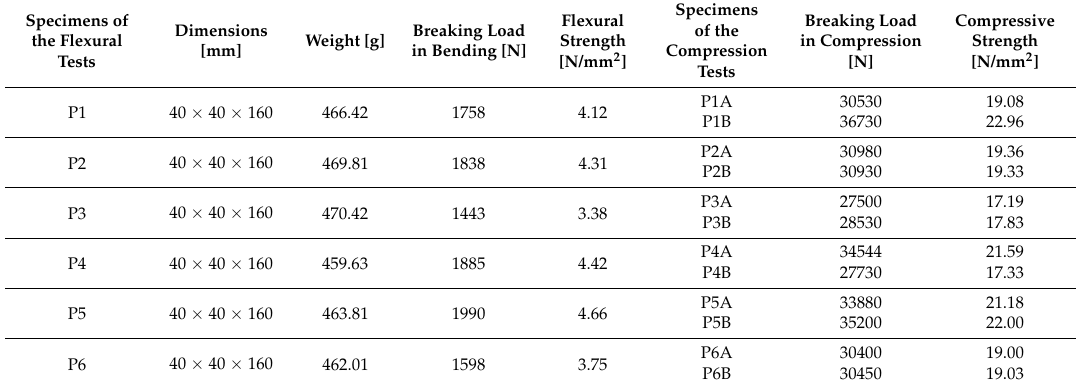
Table 2. Geometric and mechanical characteristics of the mortar specimens.